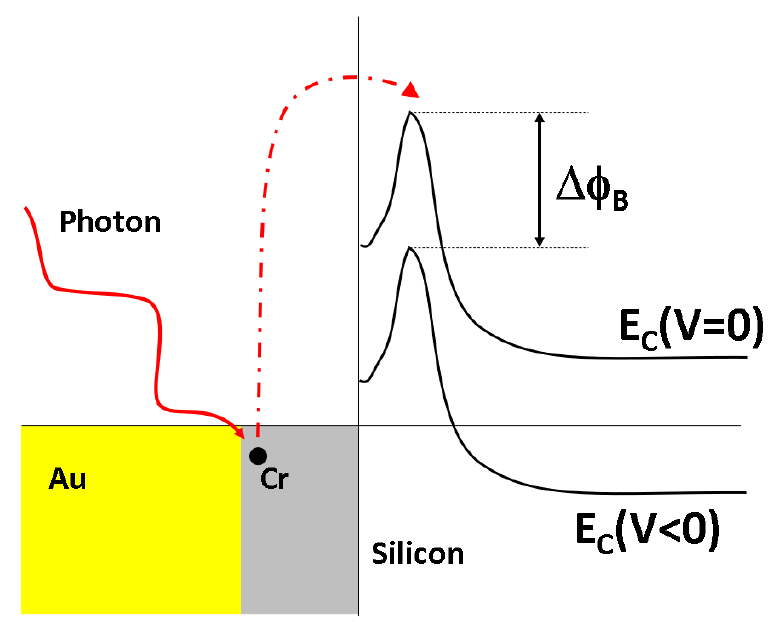
Figure 5. Band diagram of Schottky contact and IPE effect mechanism.